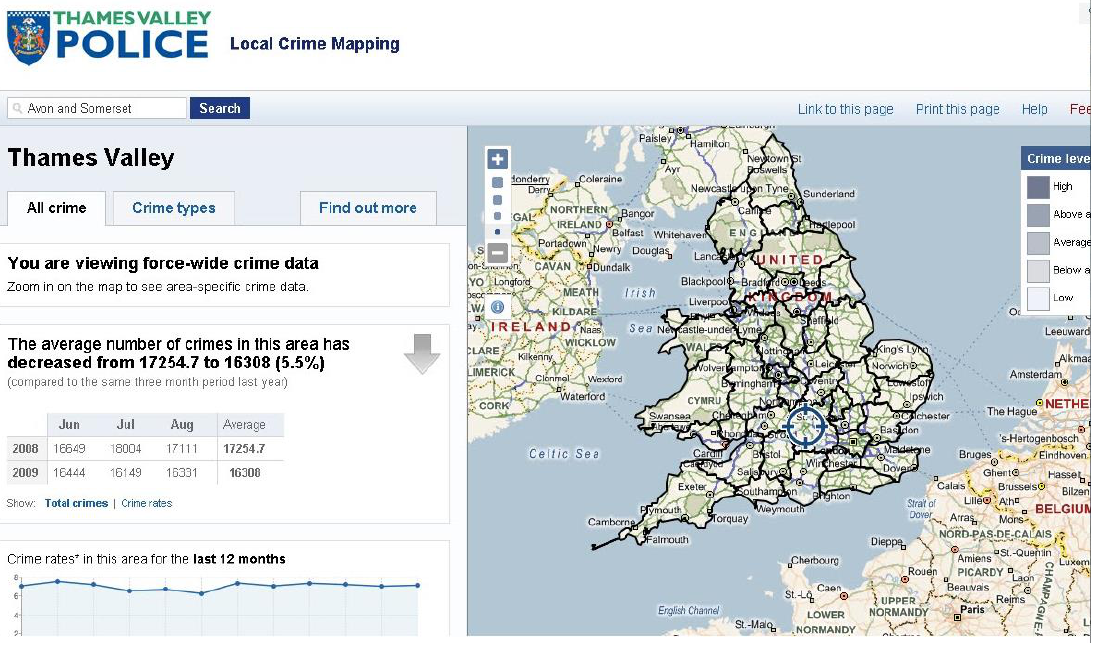
Figure 1: Screenshot of the early crime mapping website, maps.police.uk (at force level for Thames Valley Police) 14